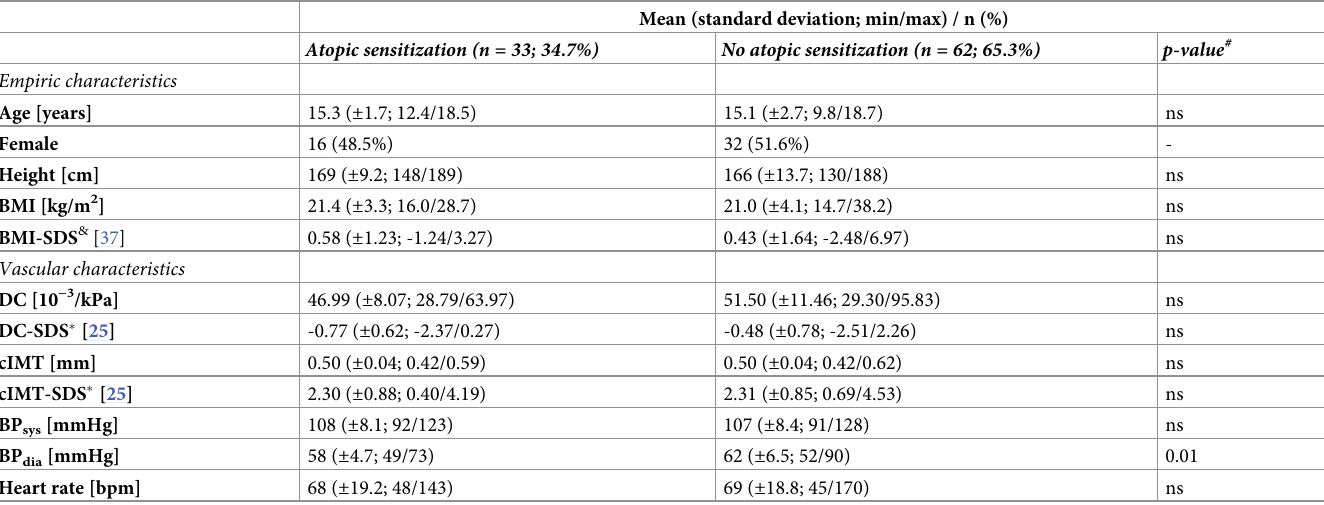
Table 1. Population characteristics.